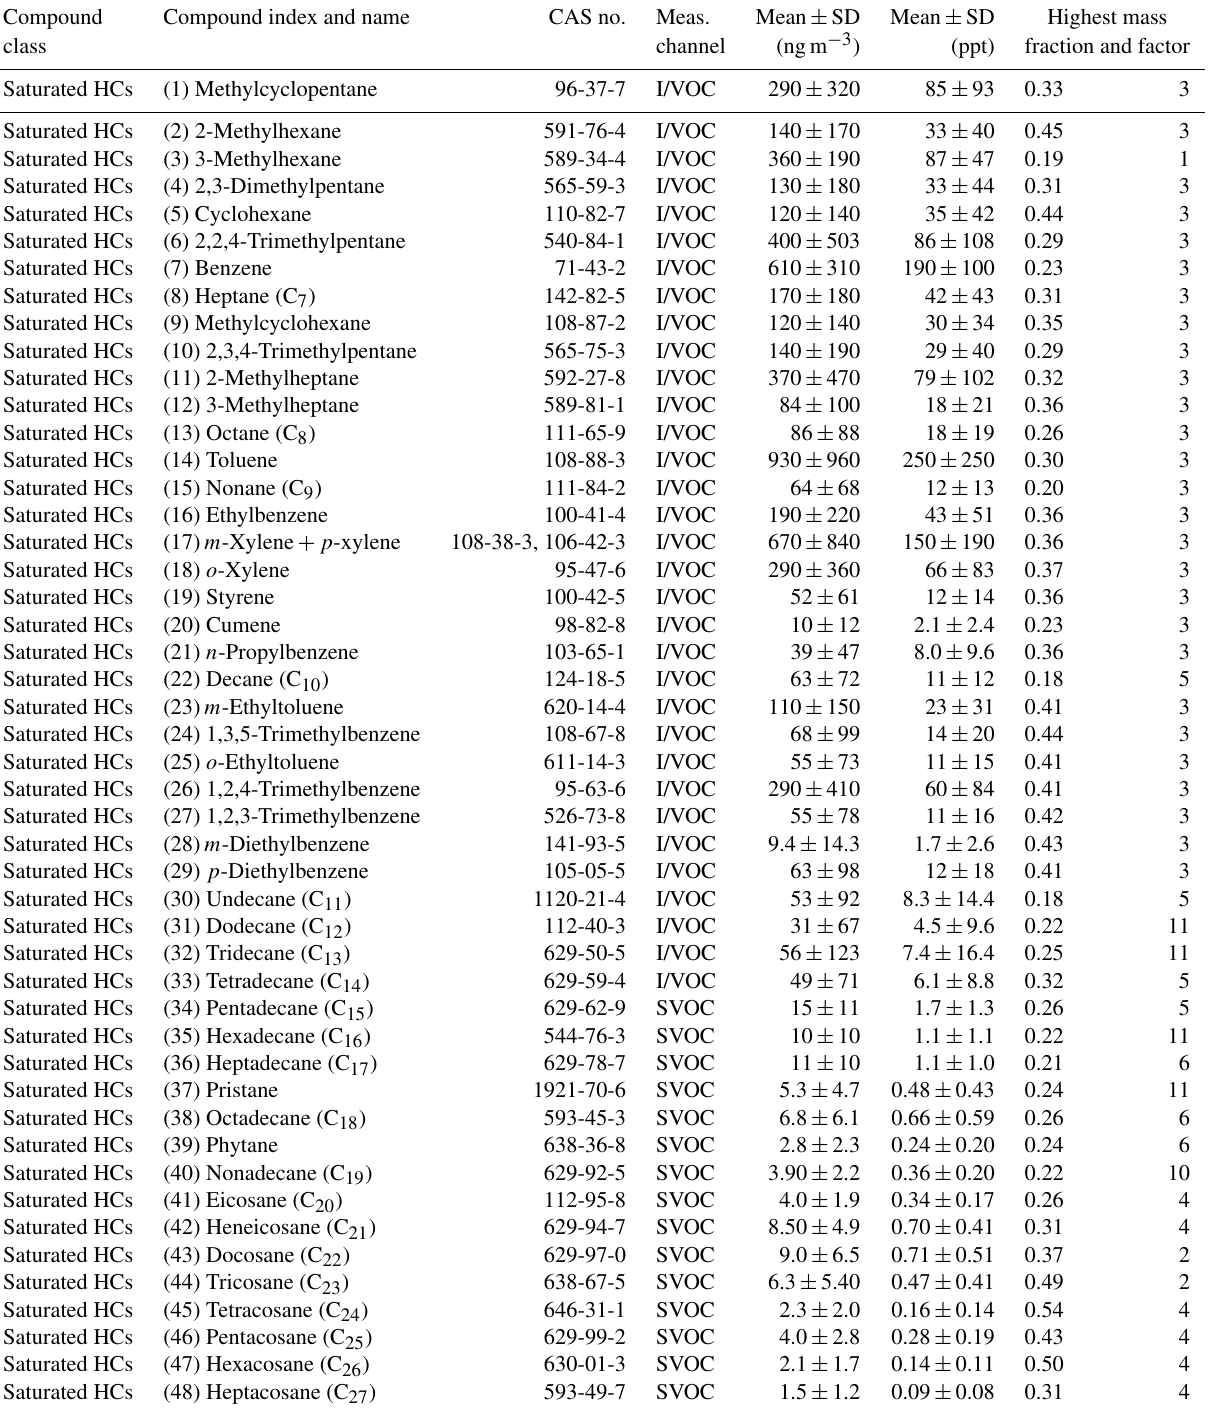
Table 1. Compounds measured by cTAG and included in the PMF analysis. The compound index is used in Figs. 2, 4–7, 10–17 and 19. PAH = polycyclic aromatic hydrocarbons; Ox. = oxidation; Alk. Acids = alkanoic acids; HCs = hydrocarbons; BB = biomass burning; THM = trihalomethanes; DCB = dichlorobenzenes; DEHA = bis(2-ethylhexyl) adipate; DEHP = bis(2-ethylhexyl) phthalate; D4 = octamethylcyclotetrasiloxane; D5 = decamethylcyclopentasiloxane; PCBTF = parachlorobenzotrifluoride; CAS no. = Chemical Ab- stracts Service Registry Number; SD = standard